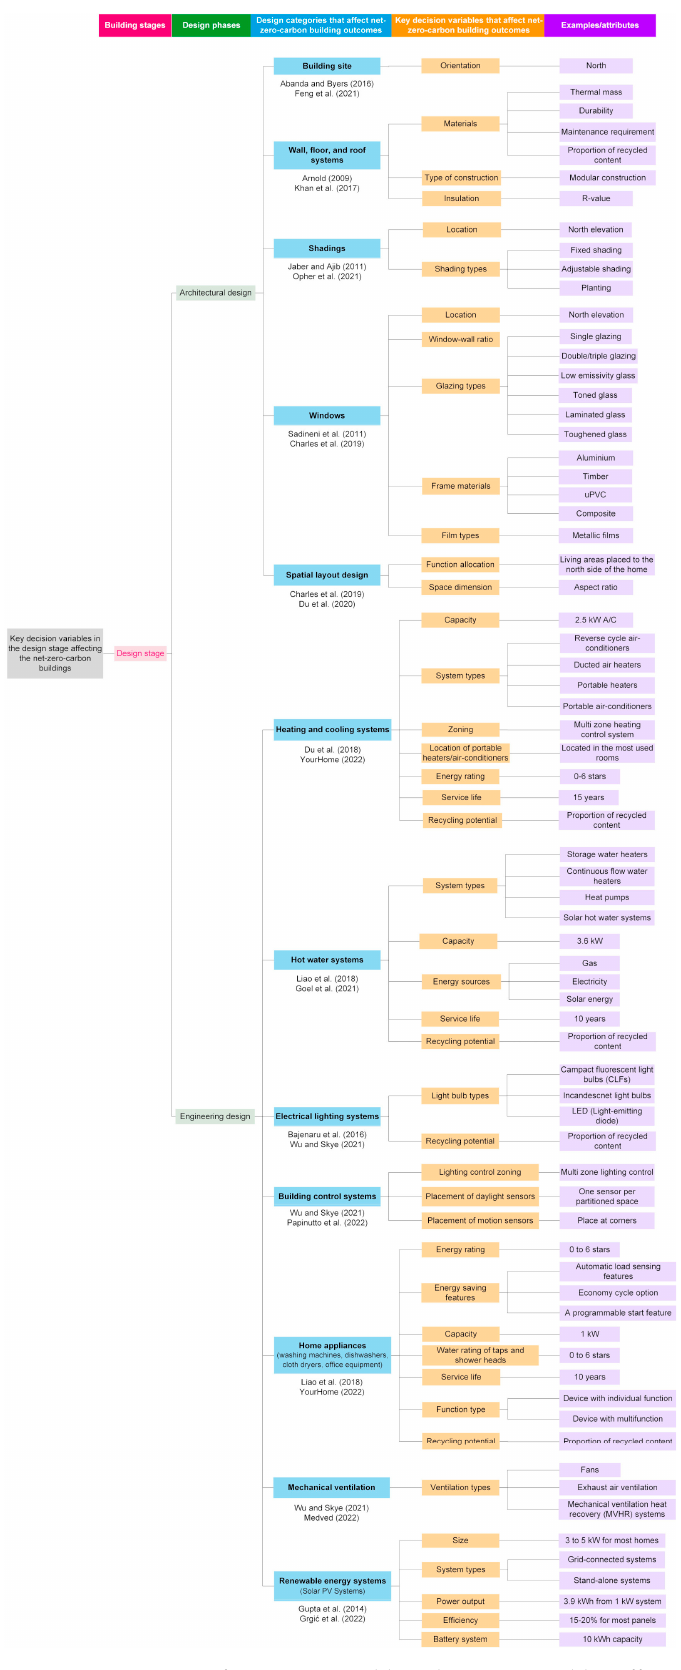
Figure 4. Summary of categories and key decision variables affecting net-zero-carbon building at design stage (key relevant references are provided to each category) [45,50,53,54,56–59,65,66,69–77].